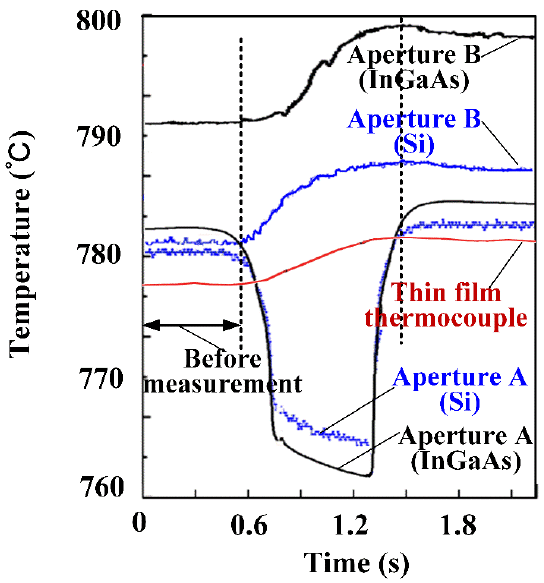
Figure 6. Schematic diagram of the temperature of Inconel 600.